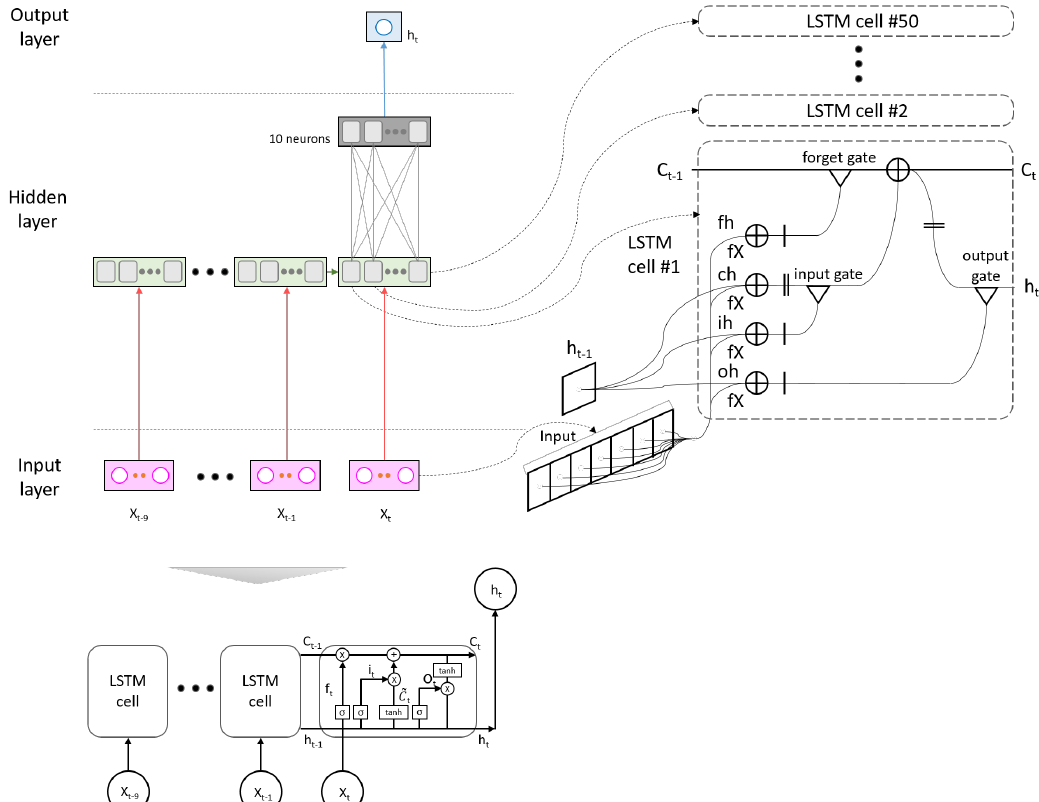
Figure 8. Our Long Short-Term Memory (LSTM) structure for the sensorless